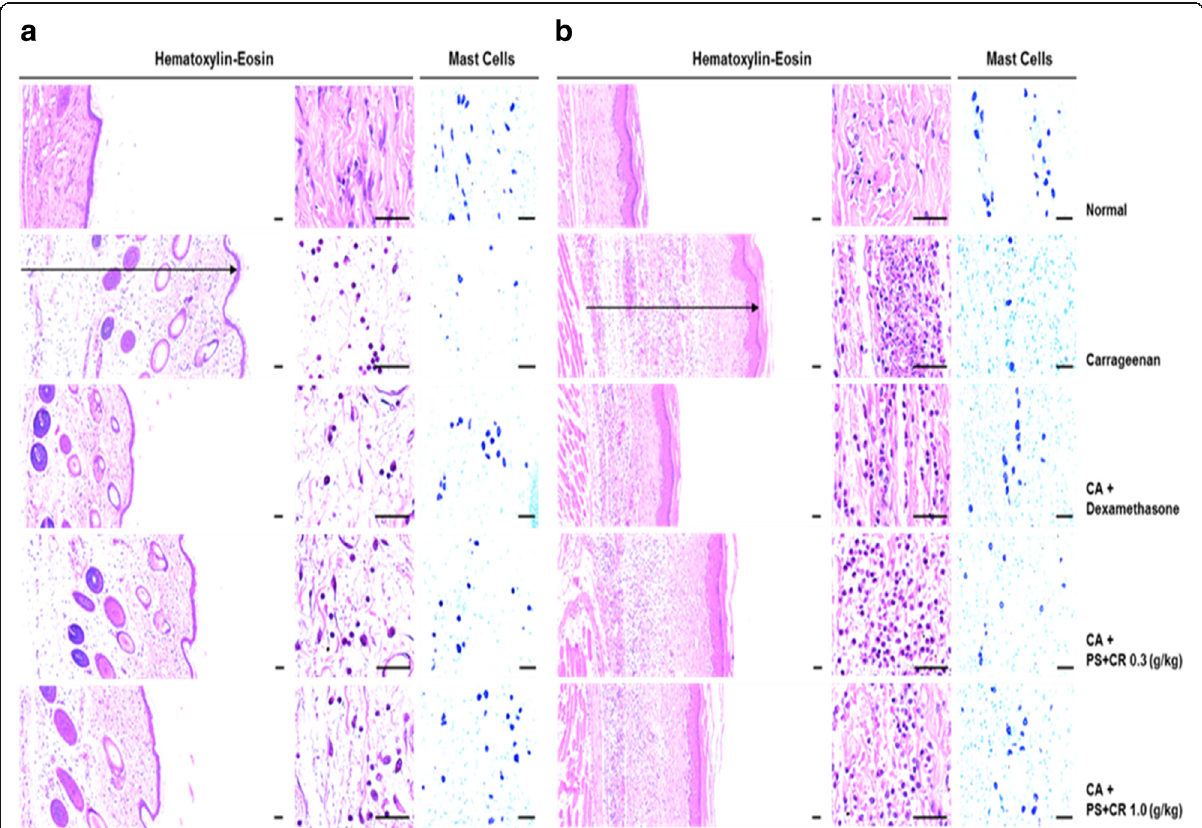
Fig. 7 Inhibition of increased paw skin thickness and infiltrating inflammatory cells by PS + CR. Histological profiles and infiltrated inflammatory cells in the dorsum pedis skin ( a ) and ventrum pedis skin ( b ). CA treatment markedly increased skin thickness (arrow) and inflammatory cell infiltration due to edematous changes. Scale bars = 60 μ